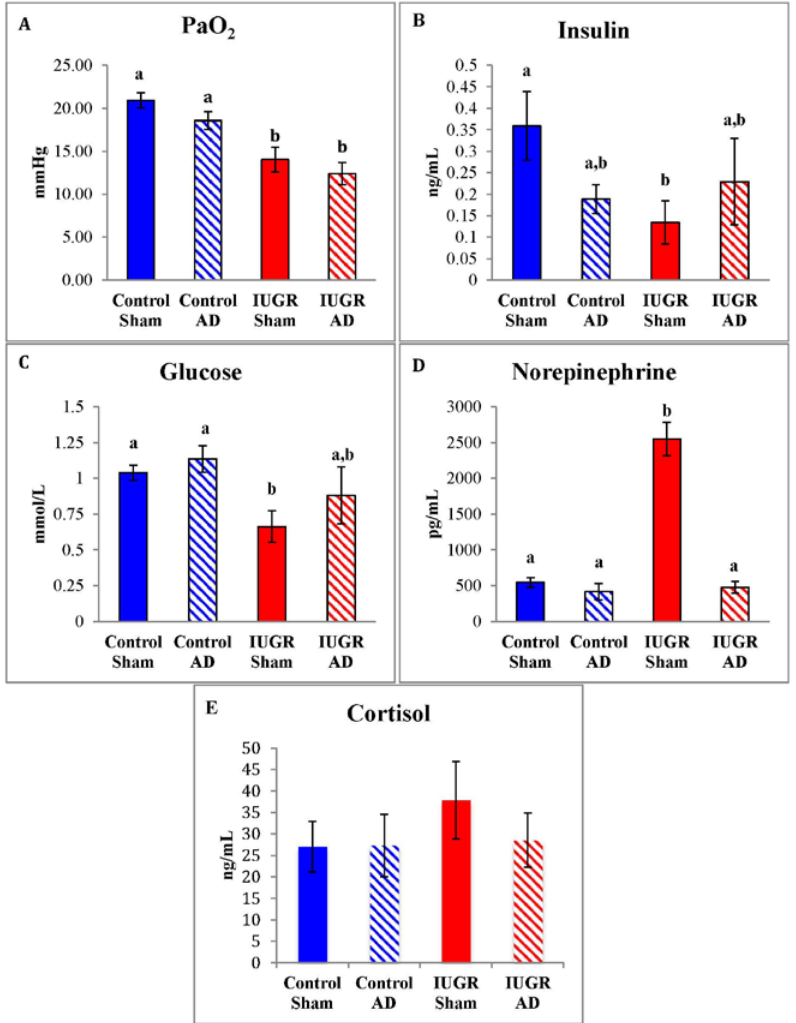
Figure 1. Fetal arterial oxygen tension and plasma glucose and hormone concentrations. Means (±SEM) for arterial blood oxygen tension (PaO 2 ; A ); insulin ( B ); glucose ( C ); norepinephrine ( D ); and cortisol ( E ) are graphed for control-sham, control-adrenal demedullation (AD), intrauterine growth restriction (IUGR)-sham, and IUGR-AD treatment groups (x-axis). Error bars represent the SEM and different superscripts denote statistically significant differences among treatment groups ( p <